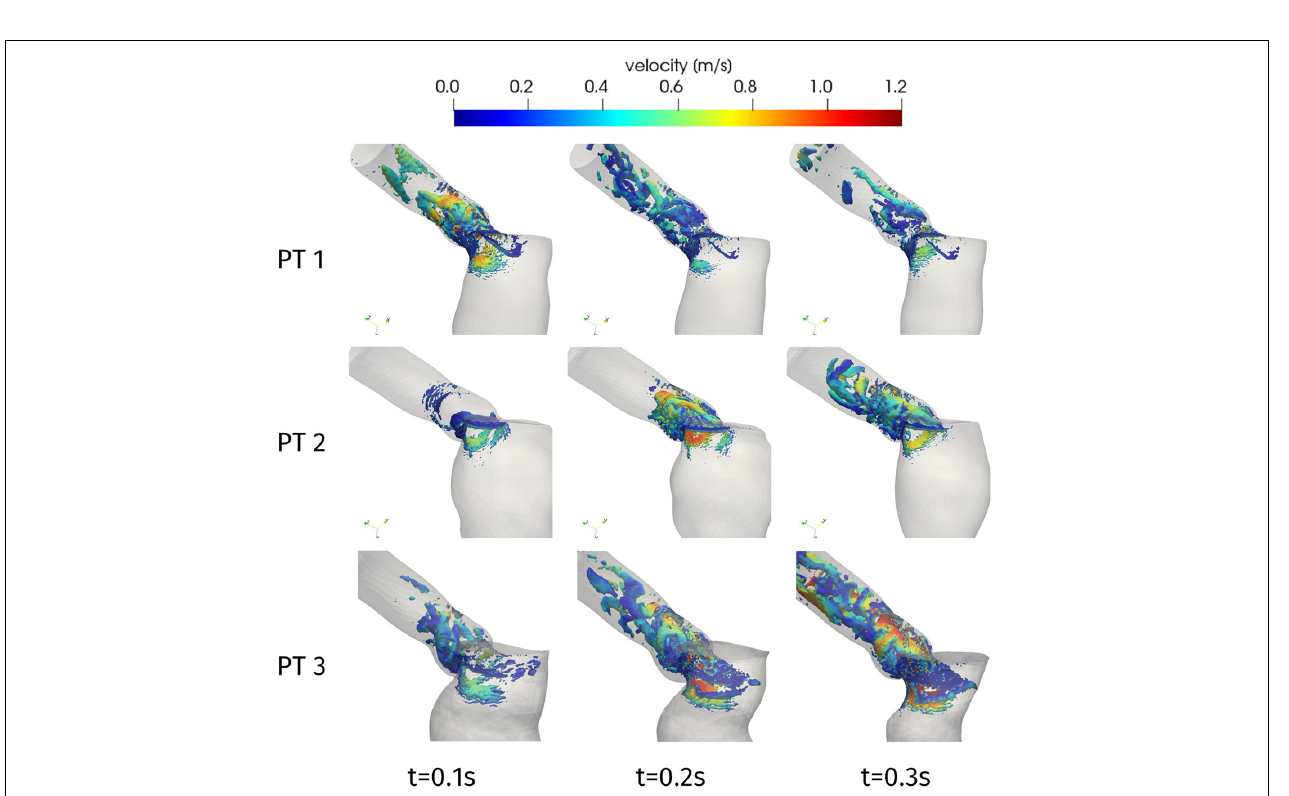
FIGURE 7 | Q-criterion contours [10 log-spaced values for Q in 2.4 × (10 4 , 10 6 ) s - 1 ] colored by velocity magnitude at significant times during systole.